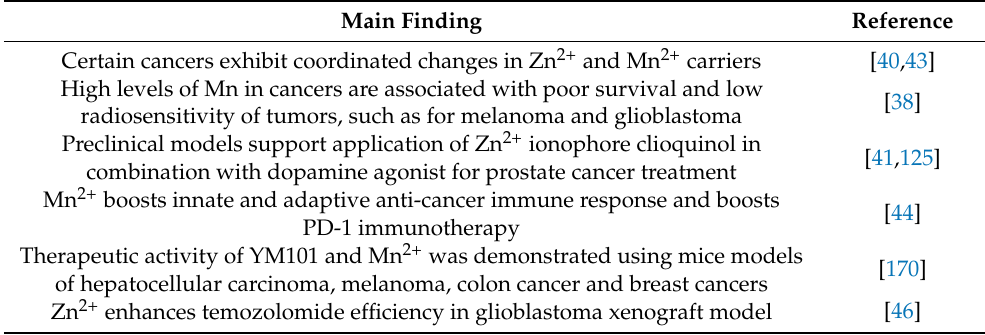
Table 2. Pivotal findings of Mn 2+ and Zn 2+ roles in cancer physiology in vivo.